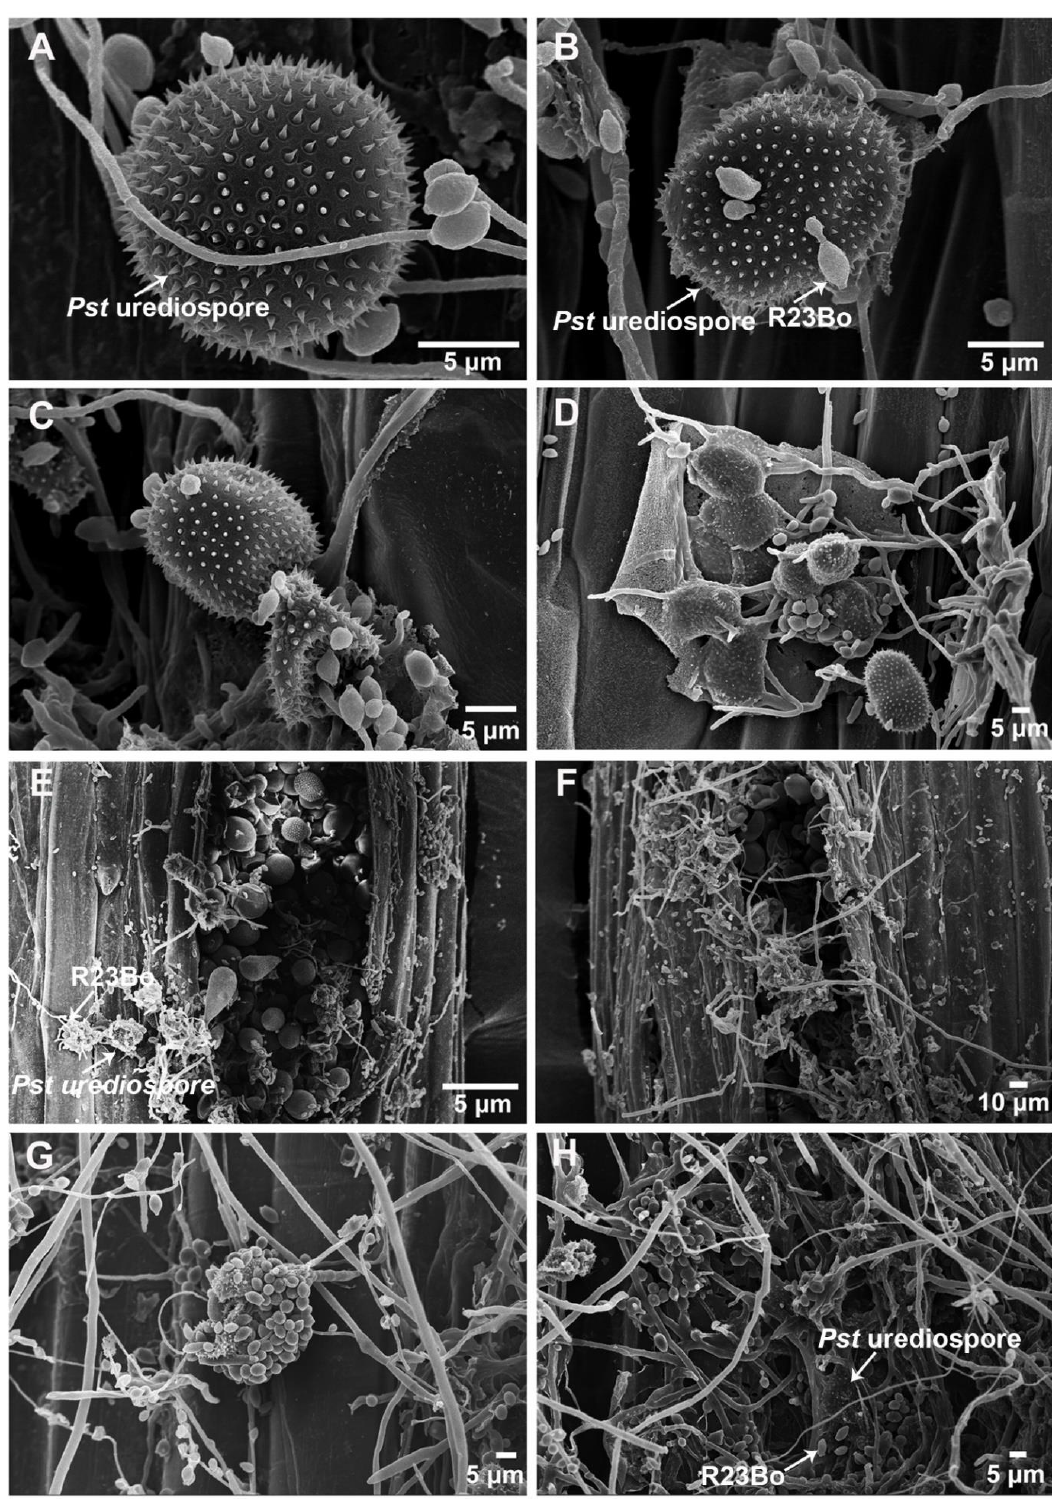
Figure 1. The hyperparasite Cladosporium cladosporioides isolate parasitized Puccinia striiformis f. sp. tritici ( Pst ) urediospores and uredinium. ( A ), urediospores of the Pst before C. cladosporioides was parasitized ( × 4000). ( B – D ), At the early hyperparasitic stage, the urediospores were shriveled ( × 3000, × 2200, × 1000, respectively). ( E , F ), At the middle hyperparasitic stage, the hyperparasite mycelia and conidia invaded the Pst urediospores ( × 400, × 400, respectively). ( G , H ), At the late hyperparasitic stage, the urediospores of the Pst are completely destroyed ( × 1000, × 800,